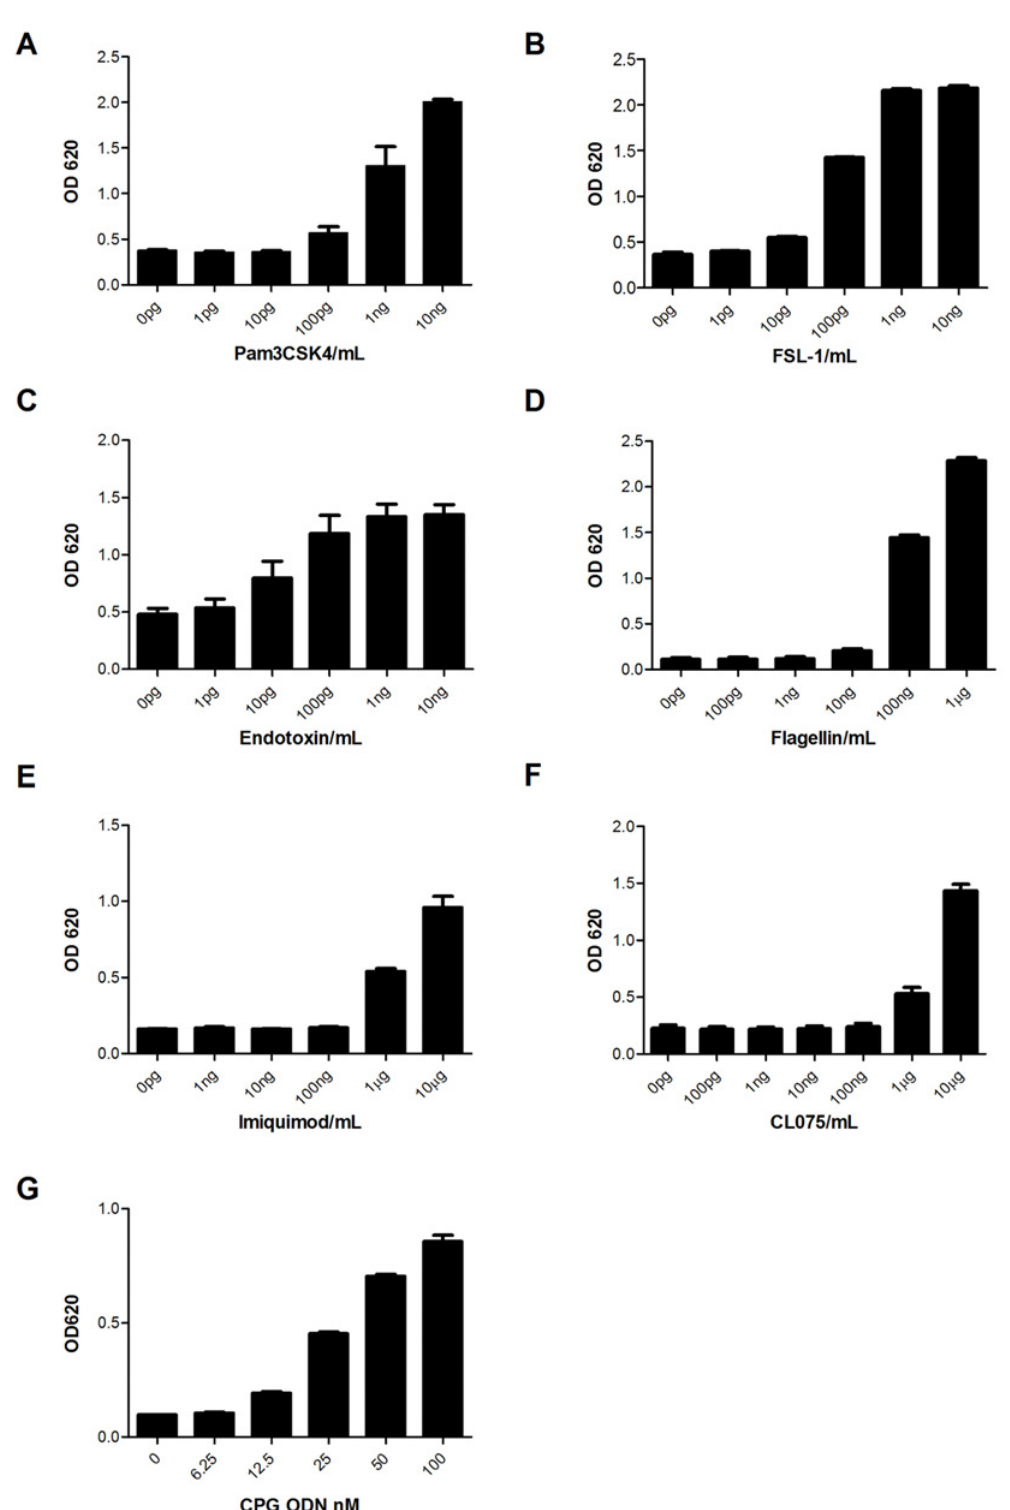
Fig 1. Dose response analysis of HEK-BLUE-hTLR transfectants to TLR stimulating IIRMIs. (A/B) A 200uL of cell suspension containing 5x10 4 HEK-BLUE-hTLR2 (C) 2.5x10 4 HEK-BLUE-hTLR4 (D) 2.5x10 4 HEK-BLUE-hTLR5 (E & F) 4x10 4 HEK-BLUE-hTLR7 (G) 8x10 4 HEK-BLUE-hTLR9 cells